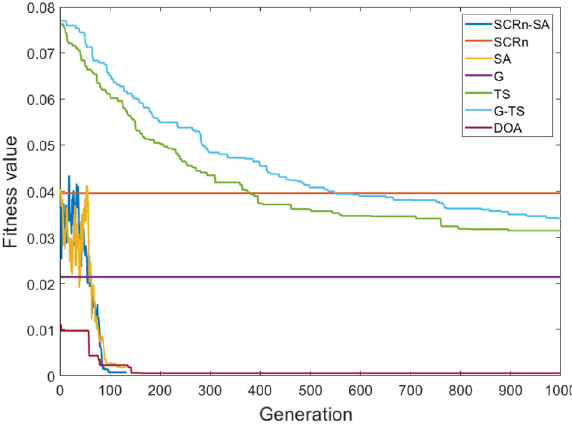
Fig. 11 Convergence curve for F 10